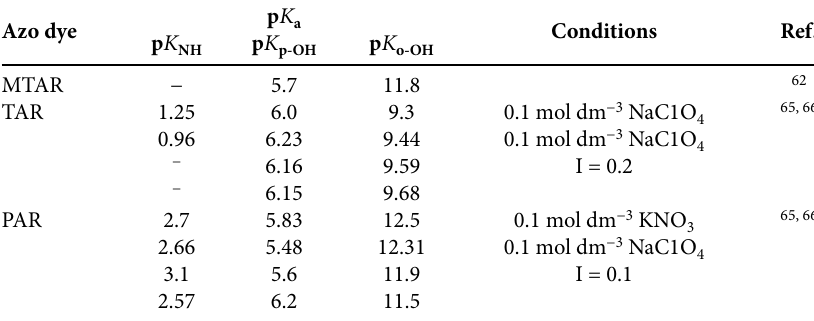
Table 2. Dissociation constants of MTAR, TAR and PAR.